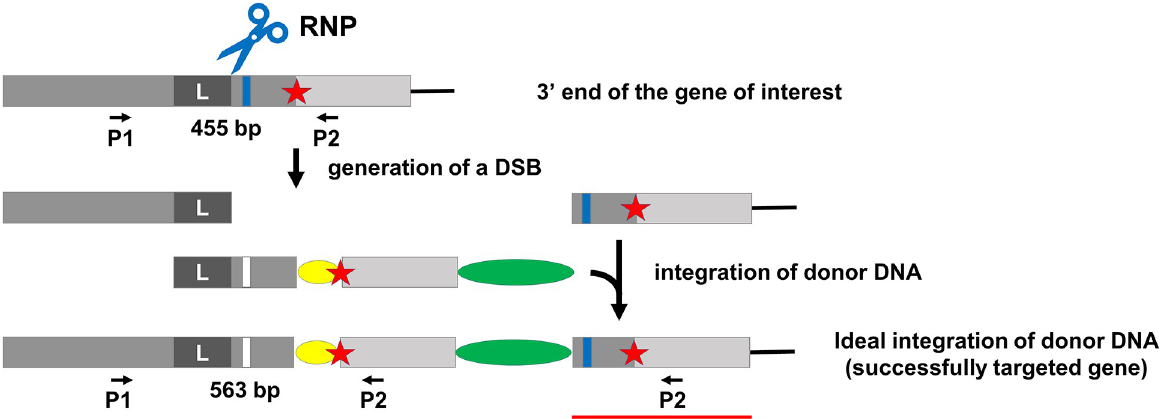
Fig 2. Schematic overview of TIM-based C-terminal tagging strategy. The target gene is illustrated at top, with the protospacer adjacent motif (PAM) shown as a blue bar and the stop codon as a red asterisk; the target RNP-cut site is located upstream of the stop codon. Donor DNA is designed to include, successively, a “left” homology arm (L) homologous to sequence upstream of the target cut site, gene sequence downstream of the target cut site, including a PAM with silent mutation (white bar on donor DNA), the desired tag sequence (yellow oval), the stop codon (red star), 3’ end non-coding sequence (light grey box), and the drug-resistance gene (green oval). The RNP can cut the wild-type gene, creating a DSB, but not the donor DNA or the tagged gene due to the silent mutation at the PAM site. When, with the help of the left homology arm, the donor DNA is inserted into the cut site without any modification, a tagged wild-type gene is formed as illustrated here. This gene carries the silent mutation at the PAM site. The drug-resistance cassette from the donor DNA is located downstream of the gene. A portion (indicated by a red line) of the original gene remains immediately downstream of the drug-resistance cassette. Following selection of colonies by growth on antibiotic-containing agar, clones are screened by PCR using a 5’-end primer (P1) complementary to sequence upstream of the donor DNA region and a 3’-end primer (P2) complementary to sequence on, or downstream of, the tag. In the latter case (shown here), product amplified from the wild-type gene will be smaller than that from the tagged gene. The sizes of the expected PCR products for the specific experiment shown in Fig 5 are indicated between the